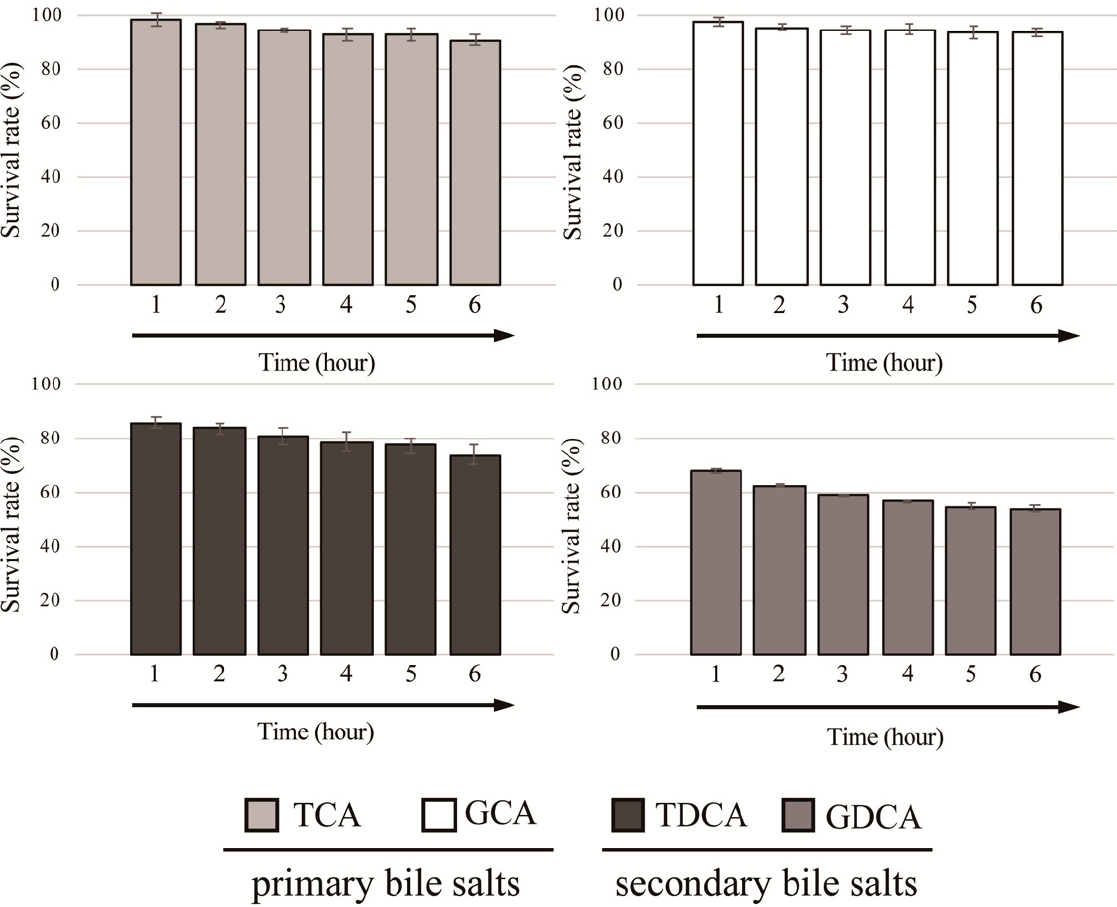
Figure 2. Bile salt tolerance activity in Lactobacillus gasseri JCM1131 T . Full-grown culture of strain JCM1131 T was mixed with GCA, GDCA, TCA, and TDCA at final concentrations of 0.05% and incubated anaerobically at 37 ◦ C. The optimal density (OD 600 ) was measured every hour and survival rates were calculated as described previously [26]. The survival rate of control (without bile salt) was defined as 100%. Results indicated mean ± SD obtained in triplicate experiments.